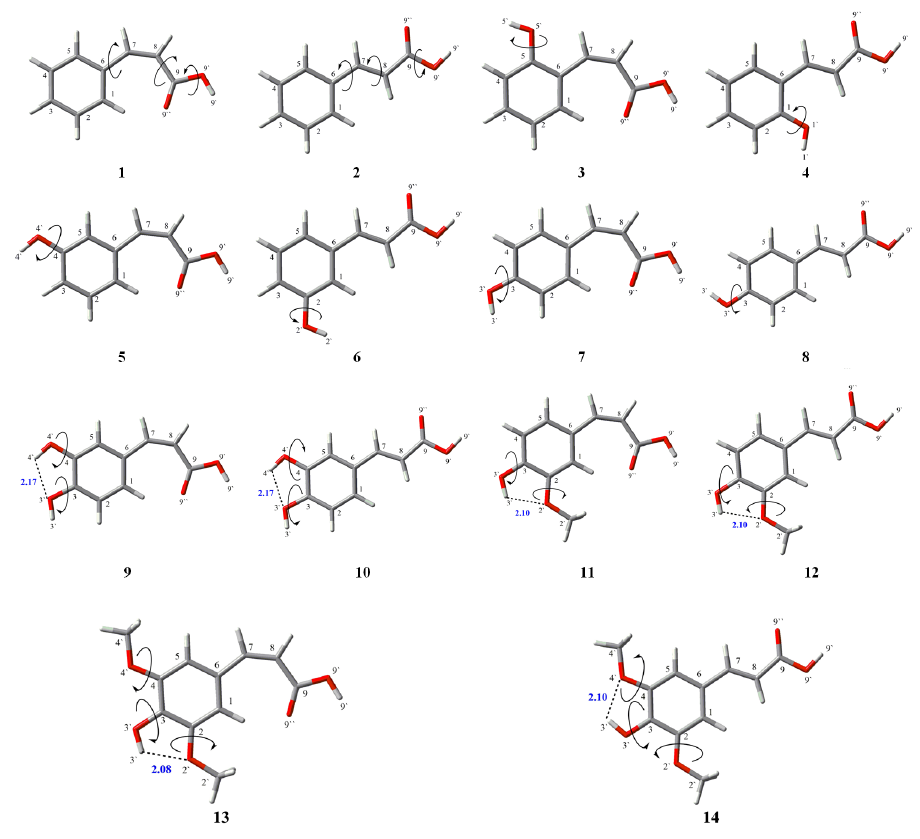
Figure 2: The rB3LYP/6-311++G(2d,2p) optimized geometries of the most stable conformers: (1) c -CiA, (2) t -CiA, (3) c - o -CA, (4) t - o -CA, (5) c - m - CA, (6) t - m -CA, (7) c - p -CA, (8) t - p -CA, (9) c -KA, (10) t -KA, (11) c -FA, (12) t -FA, (13) c -SA, (14) t -SA in vacuum. Internal hydrogen bonds with lengths [Å] and rotations leading to other conformers (curved arrows) are also included. Color representation: grey – carbon backbone, red – oxygen, white –